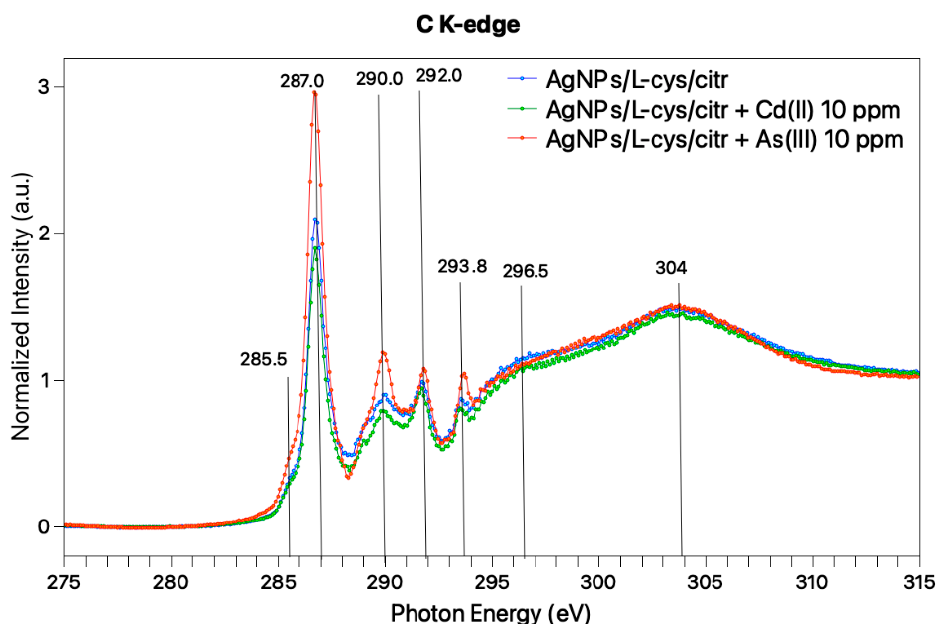
Figure 6. NEXAFS spectra collected at magic angle (57.4°) of AgNPs/L-cys/citr + As (10 ppm) ( orange ) AgNPs/L-cys/citr + Cd (10 ppm) ( green ) and pristine AgNPs/L-cys/citr ( blue ).